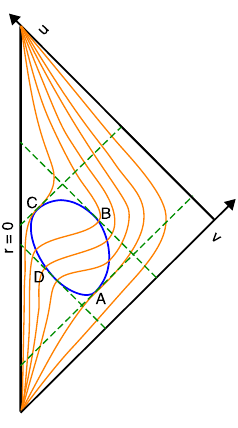
Figure 1 . The schematic Penrose diagram with a trapping horizon. The trapping horizon is shown as the solid curve (in blue). The extremal points on the trapping horizon with the extrema of the coordinates u and v are marked as A , B , C and D . The dashed lines (in green) are constant- u and constant- v lines tangent to the trapping horizon. The constant- r curves (in orange) are tangent to constant- u lines on the trapping